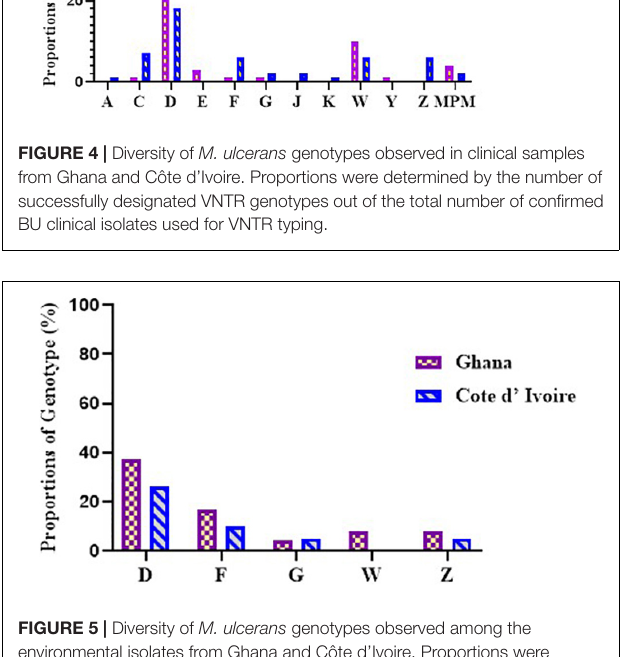
FIGURE 5 | Diversity of M. ulcerans genotypes observed among the environmental isolates from Ghana and Côte d’Ivoire. Proportions were determined by the number of successfully designated VNTR genotypes out of the total number of confirmed BU environmental isolates used for VNTR